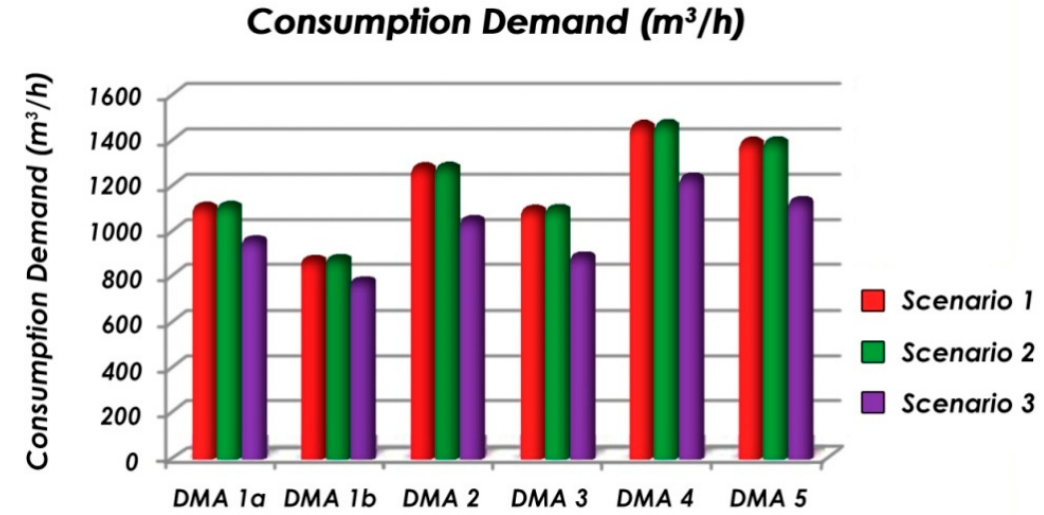
Figure 7. Water demand in each DMA for the three scenarios studied.